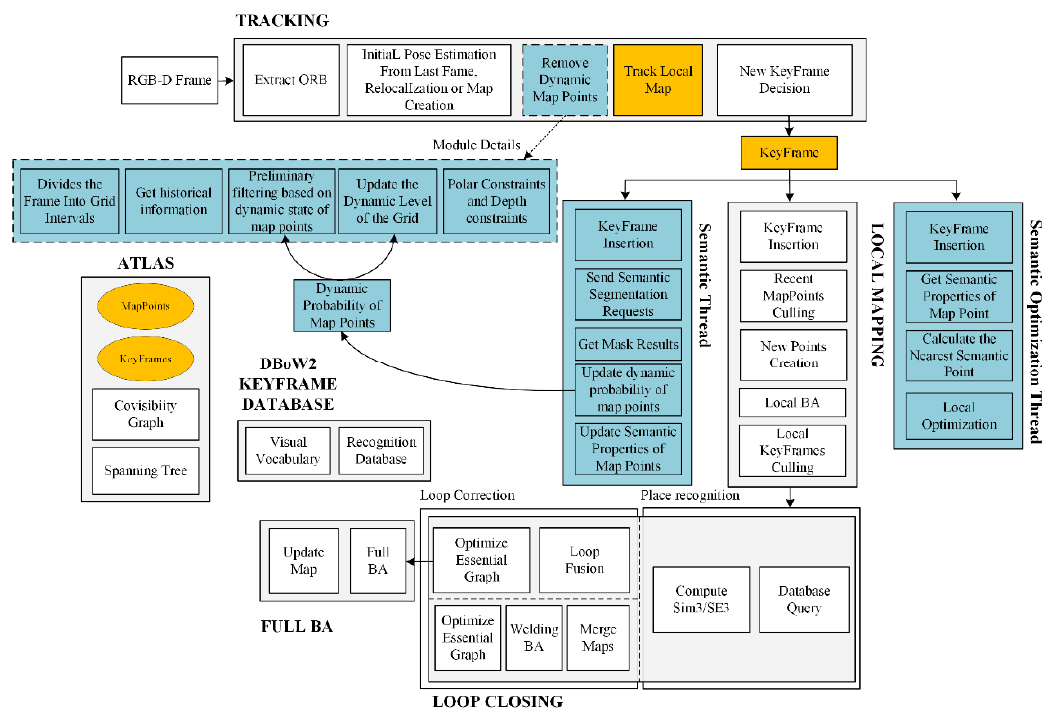
Figure 1. Overall structure of the SOLO-SLAM system (blue area is the new content added compared to ORB-SLAM3; the dashed box offers detailed description of the module; and the orange area presents the content modified).